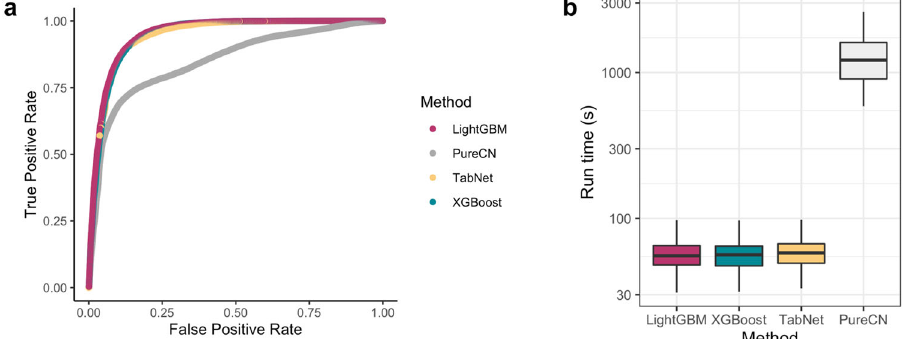
Fig. 5 Benchmark for accuracy and compute times for PureCN, TabNet, XGBoost, and LightGBM on TCGA holdout test data. a Receiver operating characteristic (ROC) curve calculated for PureCN and tabular machine-learning models, treating somatic mutations as positives and germline variants as negatives. Curves display 500 distinct posterior-probability thresholds for classi fi cation, selected by binning the probabilities into 500 quantiles. b Run-time comparison in seconds. (PureCN, 250 CPUs per sample; XGBoost and LightGBM, 1 CPU per sample; TabNet 1 CPU per sample, no GPU). Boxplots depict the median (center line), fi rst and third quartiles (bounds of box), and maximum and minimum datapoints, excluding outliers (whiskers). Outliers are datapoints more extreme than the box boundaries by a factor of 1.5 times the inner quartile range.